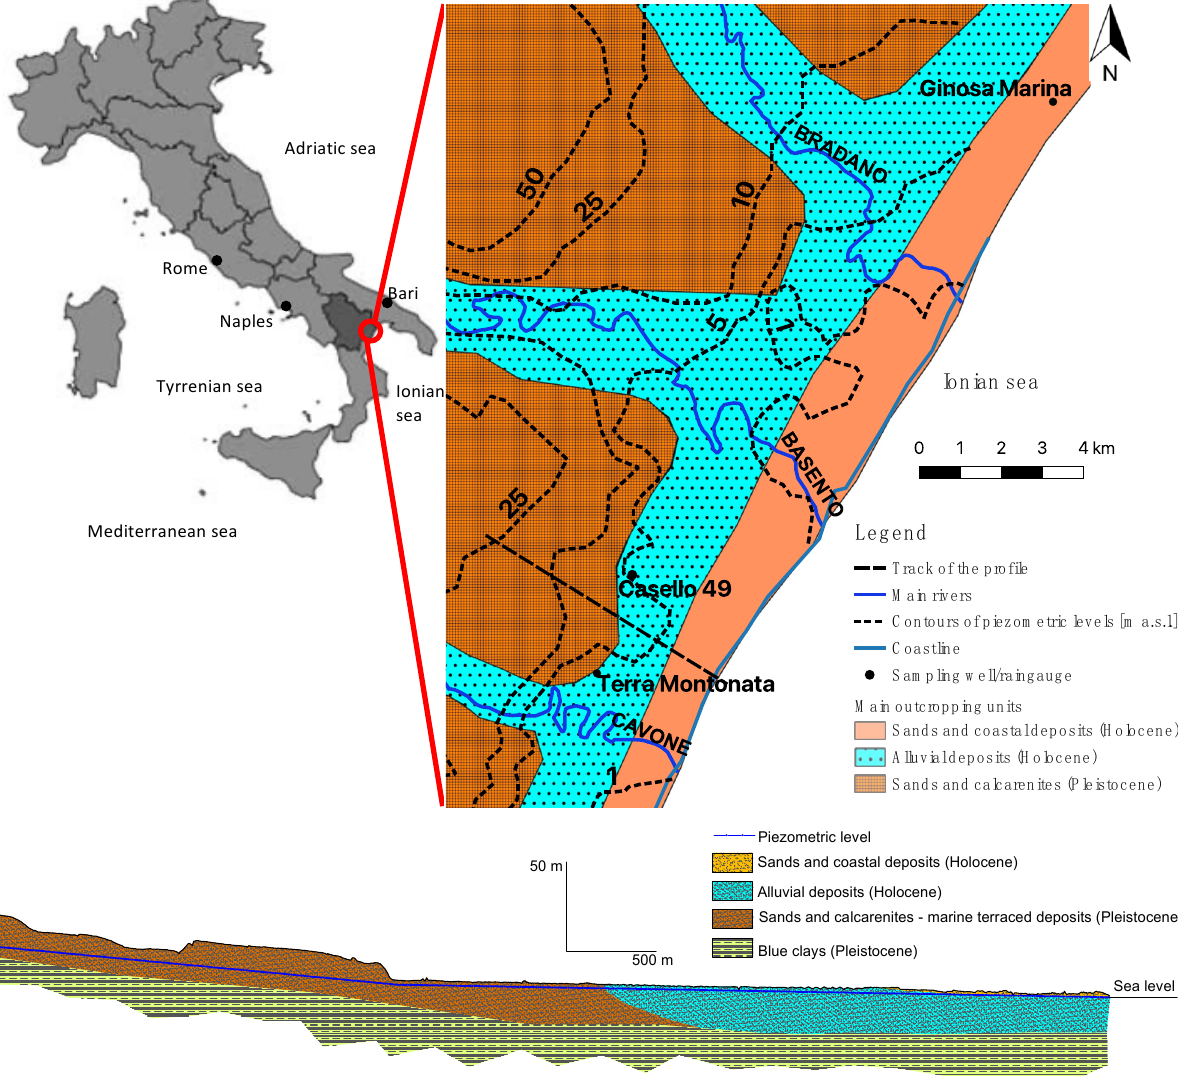
Figure 1. The catchment of the Metaponto aquifer: simplified geological map, contour lines of piezometric levels, and profile of the aquifer.